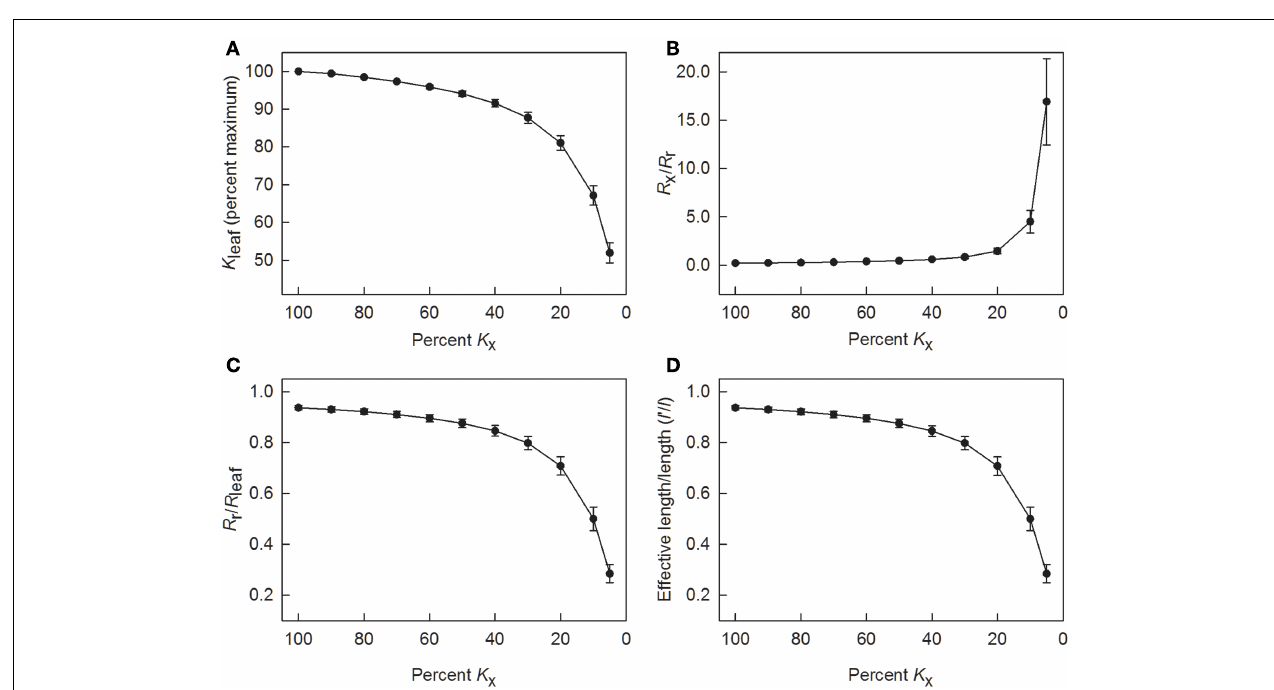
hydraulic conductance; (B) changes in the ratio of axial to radial resistance; (C) changes in the ratio of radial resistance to total leaf resistance; and (D) changes in the ratio of the effective length for leaf water uptake ( l (cid:48) ) to the actual leaf length ( l ). Data are means ± 1SE; N = 7